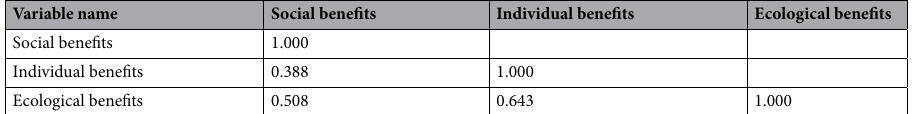
Table 4. Correlation matrix for self-perceived outcome indicators. Correlation matrix for the continuous reflective indicators (social, individual and ecological benefits) measuring the latent variable Self-perceived outcome. All correlations are significant ( p value <